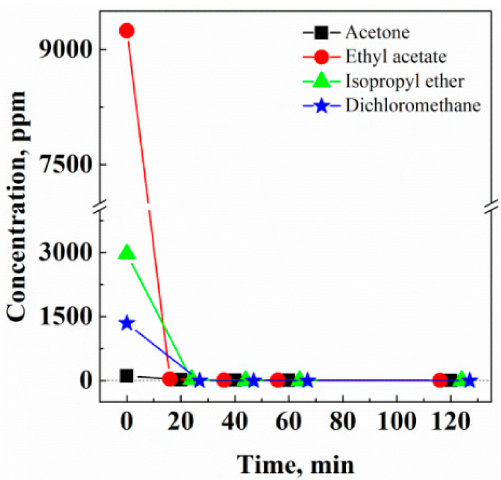
Figure 4. Solvent extraction kinetics from Fluni, working at 200 bar, 40 ◦ C, and 0.7 kg/h CO 2 flow